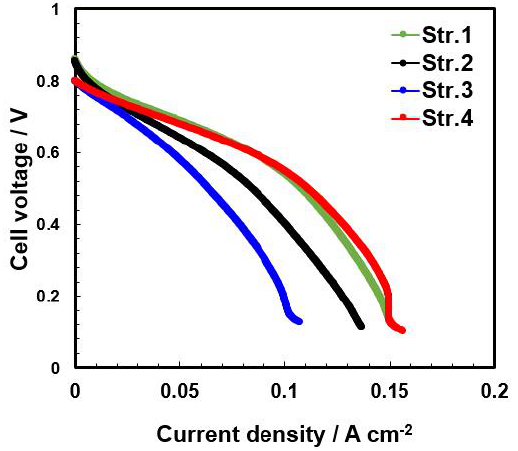
Figure 10. ( a ) Impedance spectra and ( b ) charge transfer resistances of the four CCLs at 0.6 V, 80 ° C , and 40% RH.